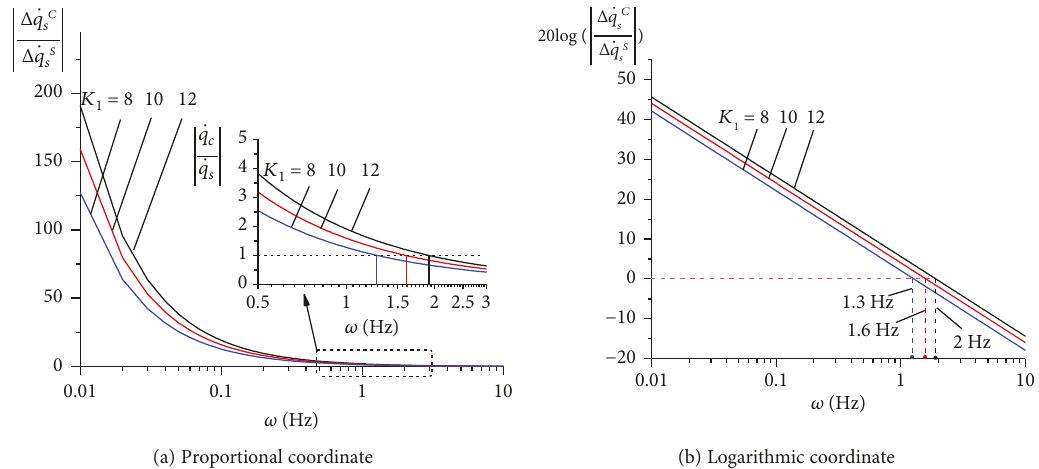
Figure 4: The DRR amplitude ratio of the C point to the S